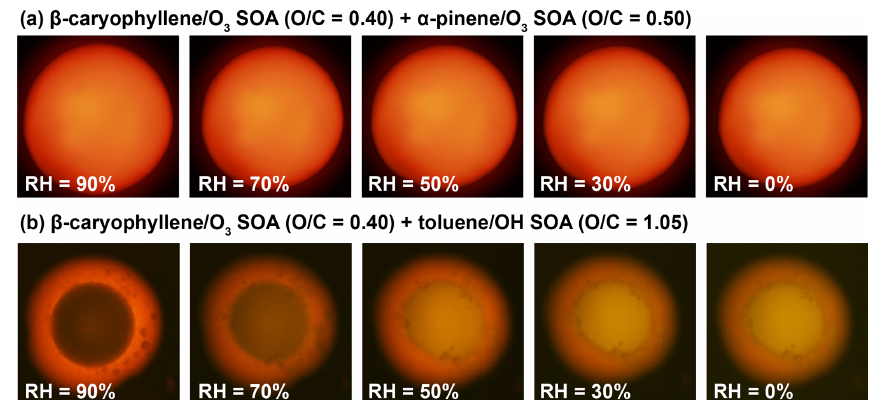
Figure 2. Example fluorescence microscopy images of internally mixed particles of two different types of SOA material at different relative humidity (RH) levels. (a) Mixture of SOA materials derived from β -caryophyllene and α -pinene ozonolysis, showing single-phase particles between 90% and 0% RH. (b) Mixture of SOA material derived from β -caryophyllene ozonolysis and toluene photooxidation, showing phase-separated particles between 90% and 0% RH. The colors result from trace amounts of Nile red within the SOA + SOA particles, and the presence of different colors indicates the presence of multiple phases. Also indicated above each row is the average elemental oxygen-to- carbon (O / C) ratio of each SOA type, as determined from aerosol mass spectrometer measurements. Images were recorded for RH values decreasing from high to low values. The small inclusions in the outer phase of the β -caryophyllene SOA and toluene SOA mixture represent an emulsified, transient morphology.